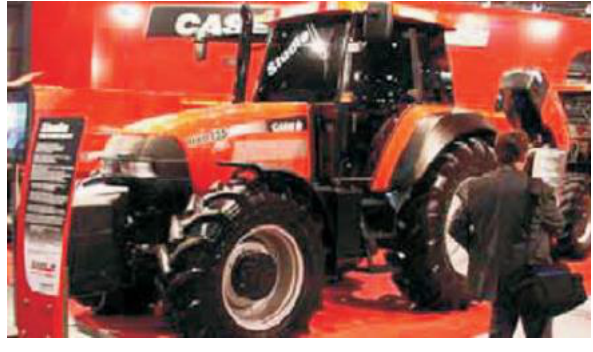
Fig. 34. Case ProHybrid EECVT [14]